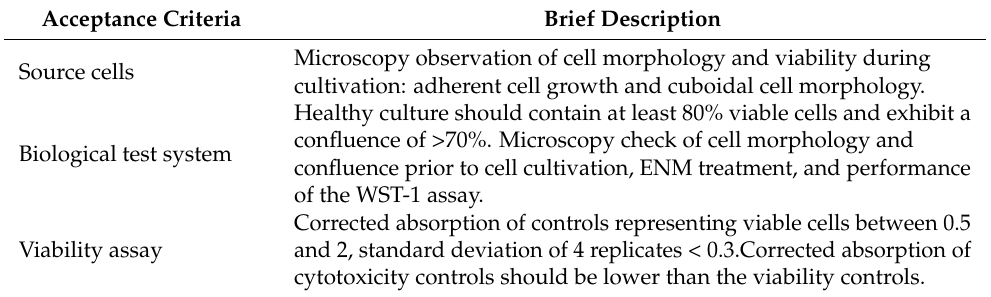
Table 1. Acceptance criteria to be fulfilled within the modules’ biological model and endpoint read out